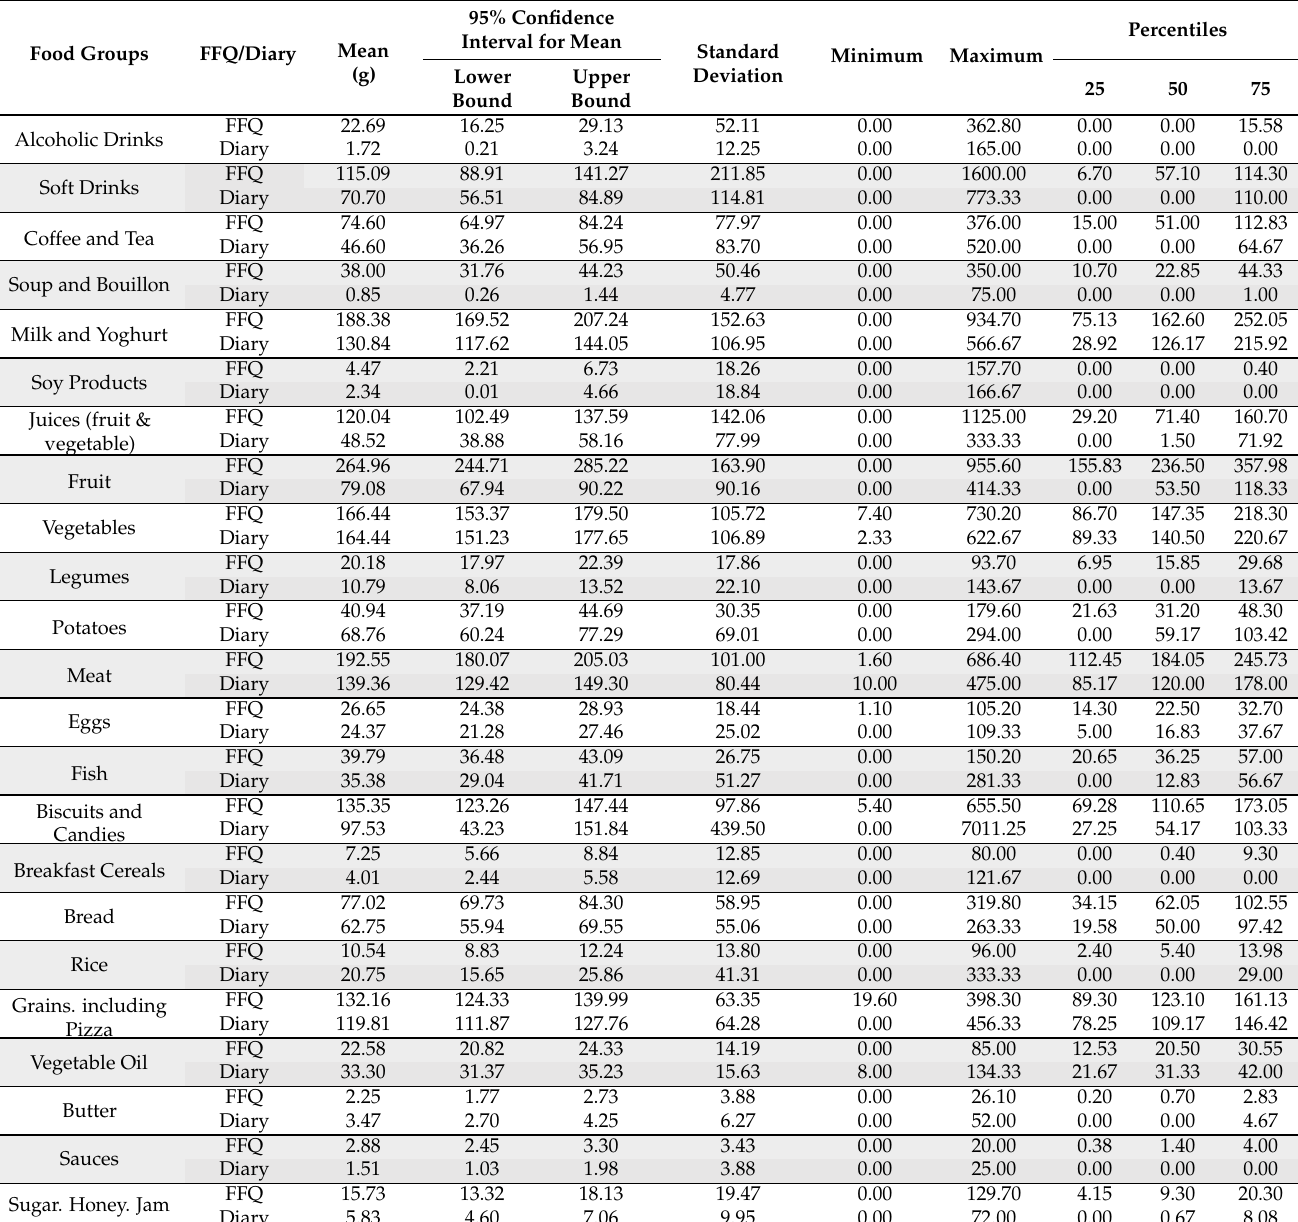
Table 1. Food groups description of the total study population (mean ± standard deviation; Min, P25, P50, P75 and Max; 95% confidence interval); n =